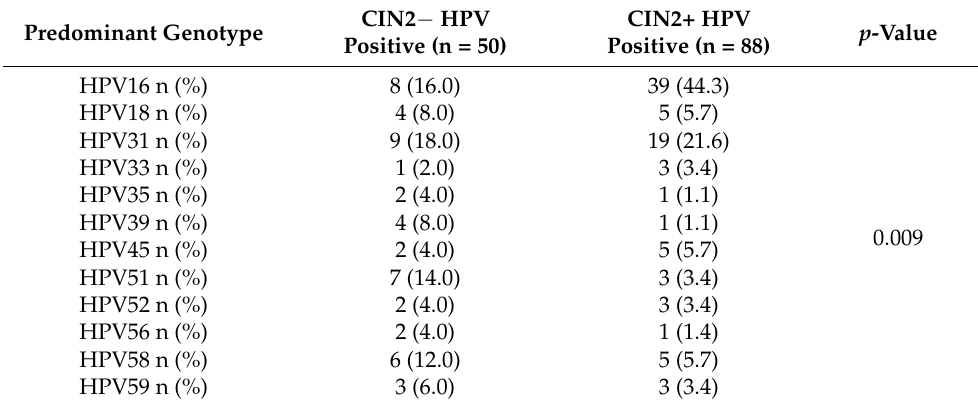
Table 4. HR-HPV genotype distribution detected in women with high-grade and low-grade cervical dysplasia by OncoPredict HPV ® QT